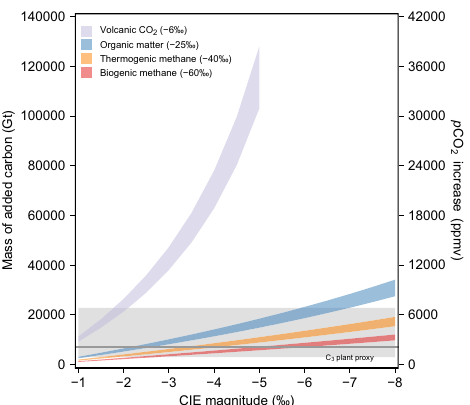
Fig. 4 Mass of added carbon estimated from carbon isotope mass balance calculation. Four different scenarios including volcanic CO 2 ( δ 13 C = − 6%), organic matter ( δ 13 C = − 25%), thermogenic methane ( δ 13 C = − 40%) and biogenic methane hydrate ( δ 13 C = − 60%). Second y-axis converts the mass of added carbon to an increase in atmospheric p CO 2 based on the earth system model (1 Gt C = 0.3ppmv CO 2 ) 55,56 . Gray shaded area represents the 68% con fi dence intervals of p CO 2 increase (2081 + 4764/ − 1193ppmv) estimated from the C 3 plant